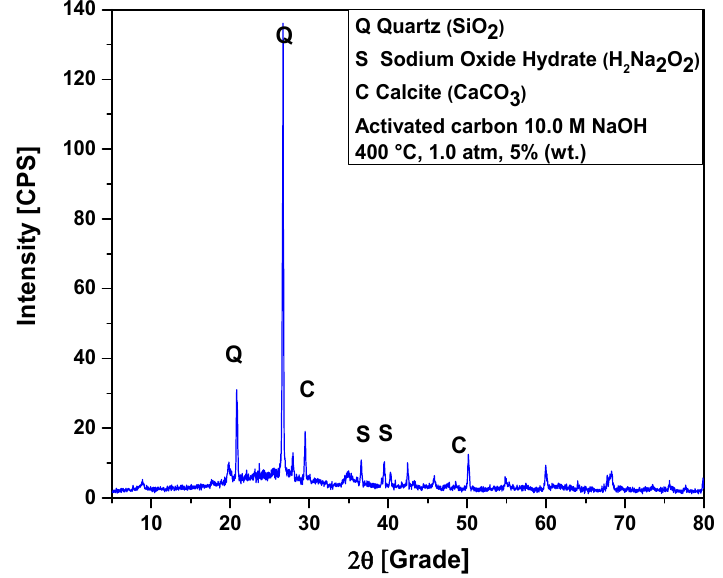
Figure 10. XRD of activated carbon pellets impregnated with 10.0 M NaOH after the upgrading of residual fat pyrolysis vapors at 400 °C, 1.0 atmosphere, 5.0% (wt.) activated carbon pellets impregnated with 10.0 M NaOH, using a catalyst fixed-bed reactor, in a semi-pilot scale two-stage reactor of 2.0 L.